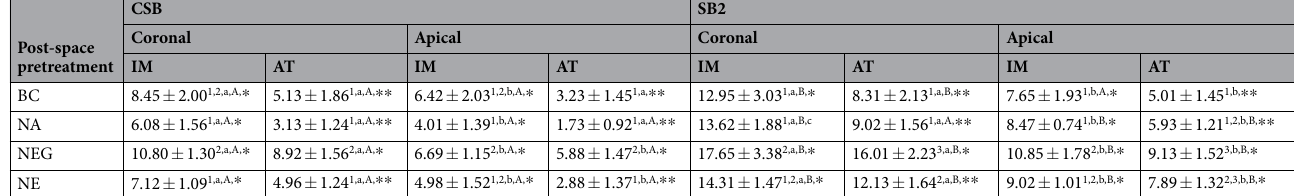
Table 1. Push-out strength values (n = 24; MPa; mean ± standard deviation). * For each vertical column, values with identical numbers indicate no significant difference (P > 0.05). For each horizontal row, values with identical lowercase letters indicate no significant difference between root regions within the same adhesive system and the same time (P > 0.05), values with identical uppercase letters indicate no significant difference between adhesive systems within the same root region and the same time (P > 0.05), and values with identical number of asterisks indicate no significant difference between time within the same adhesive system and the same root region. IM, Immediate; AT, After